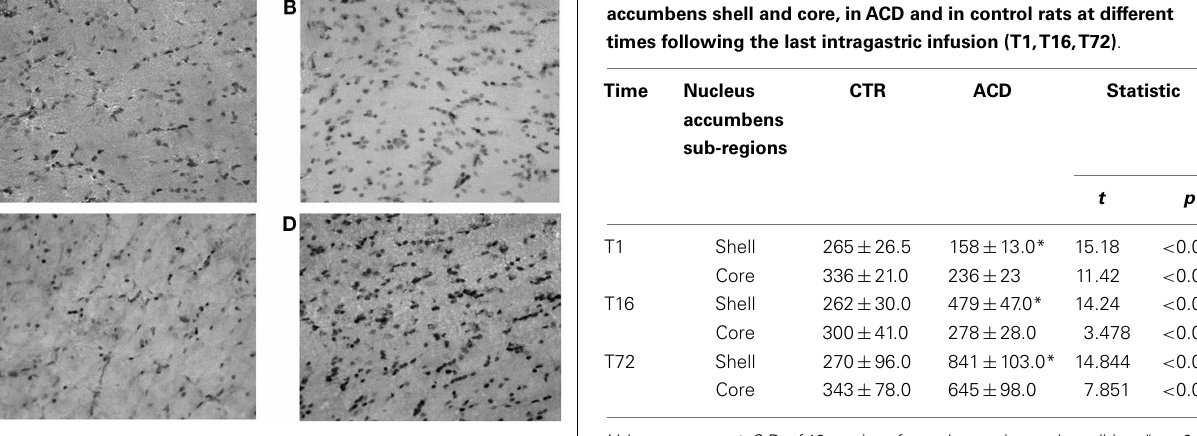
FIGURE 5 | Microphotographs of neuropeptideY (NPY)-positive neurons in rat nucleus accumbens (shell); (A) controls; (B)ACD rats at T1; (C)ACD rats atT16; and (D)ACD rats atT72 .The specific labeling is observed under bright-field illumination using a 100 × objective.